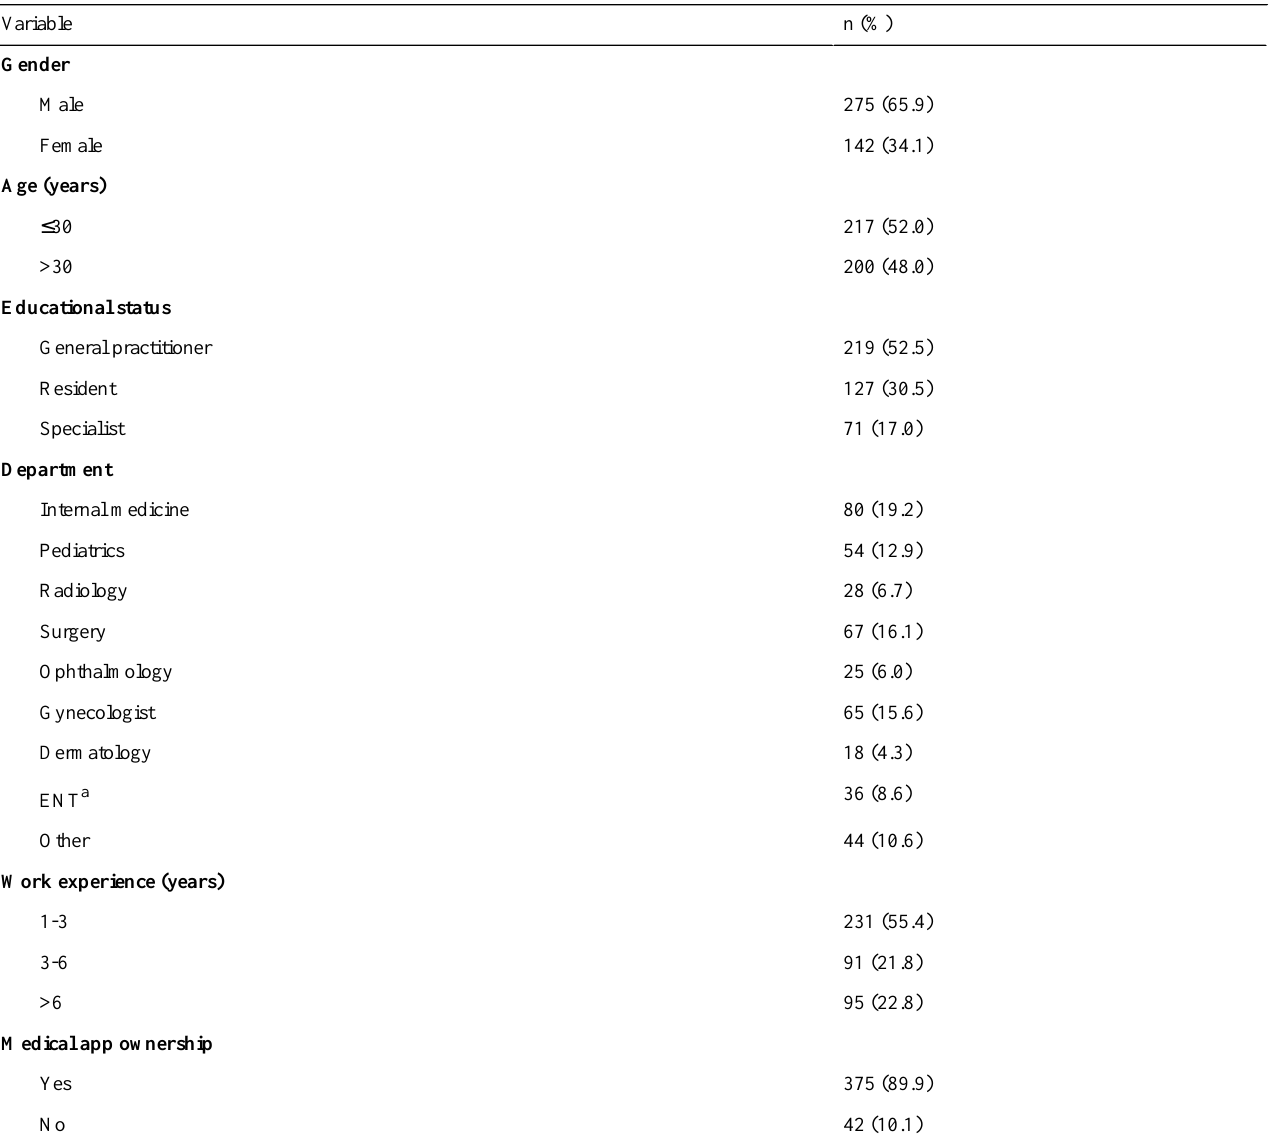
Table 2. Sociodemographic characteristics of respondents working at referral hospitals of Amhara region, North Ethiopia, 2019